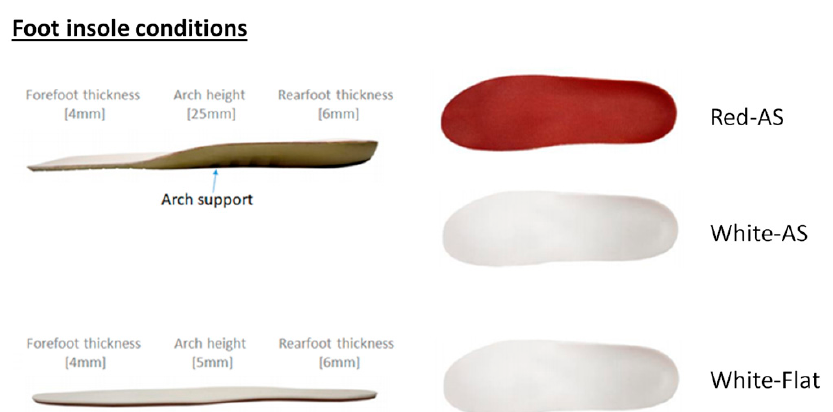
Figure 1. The thickness across forefoot, midfoot and rearfoot regions in each of three insole conditions (red arch-support (Red–AS), white arch-support (White–AS), white control (White–flat).